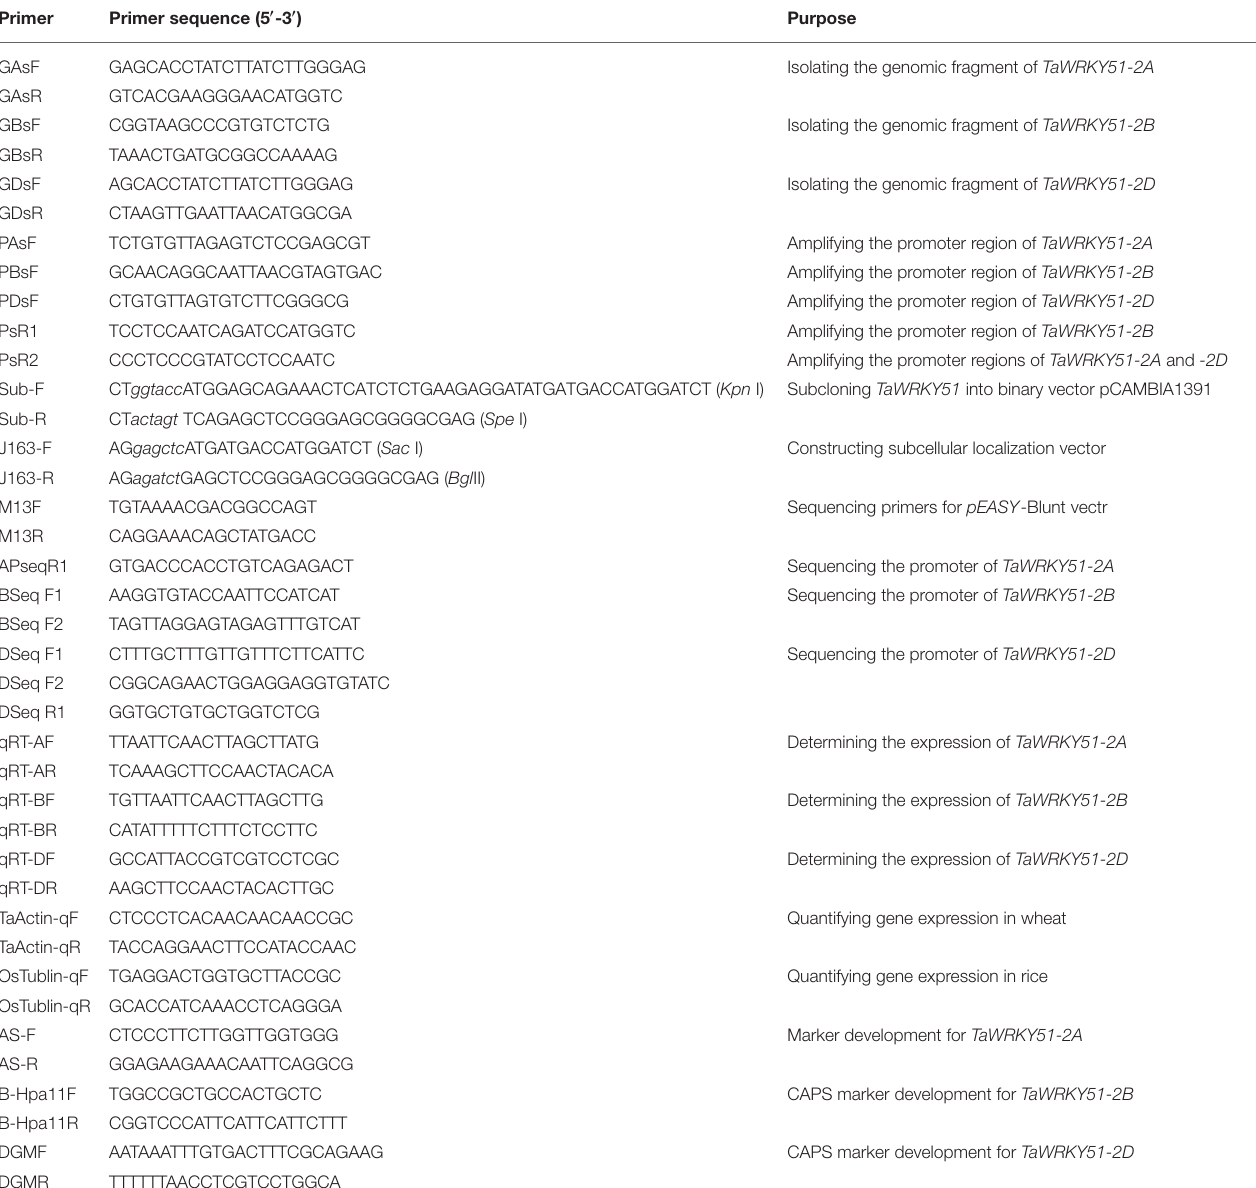
TABLE 1 | The primers used in the current study for various purposes.